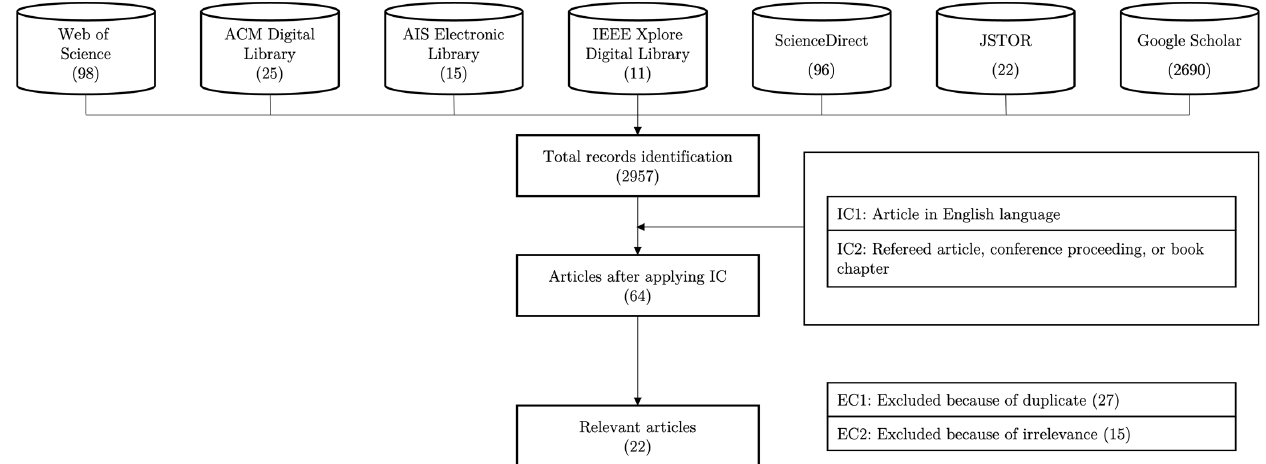
Figure 1. Sample identification